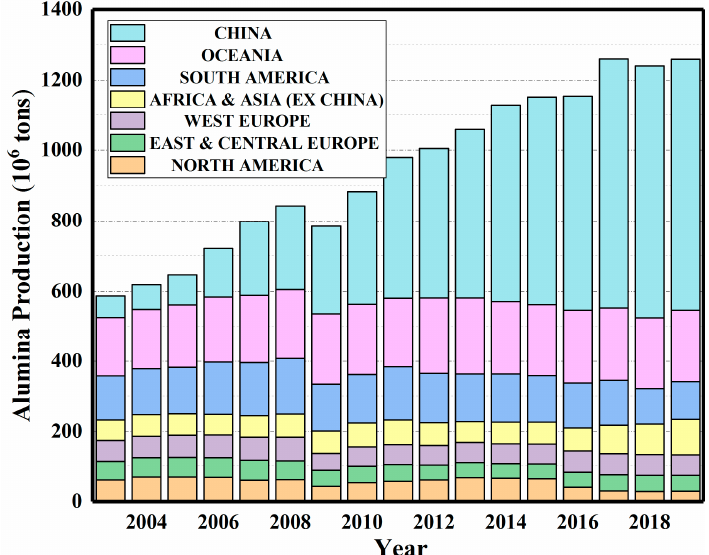
Figure 1. Global alumina accumulated amounts during recent twenty years (data from the International Aluminum Institute [3]).